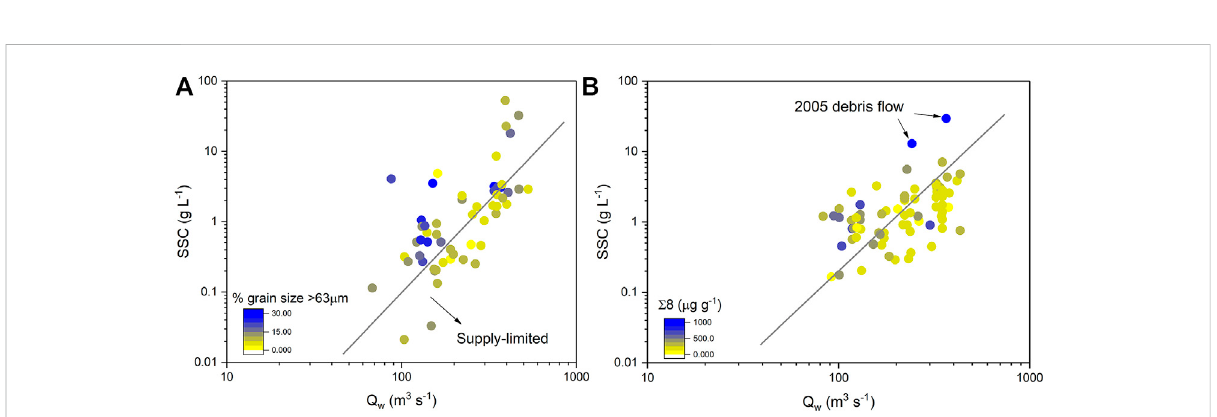
FIGURE 5 Thepower-lawrelationshipbetweenwaterdischarge( Q w )andsuspendedsedimentconcentration(SSC)attheZagunaoRiver(stationD2).The colorsofthecircleshow (A) thefractionofcoarsesedimentand (B) concentrationofligninphenols( Σ 8 ).Thegreylinesshowthepotentialseparation of supply-limited and transported limited scenarios. The scatter of data is due to relationship between the sediment availability (supply) and river transportcapacity.Forthesampleinthelowerrightofline,thelowSSCislimitedbythesedimentsupply,whiletheSSCintheupperleftcorneris limited by the river transport capacity (Hovius et al.,